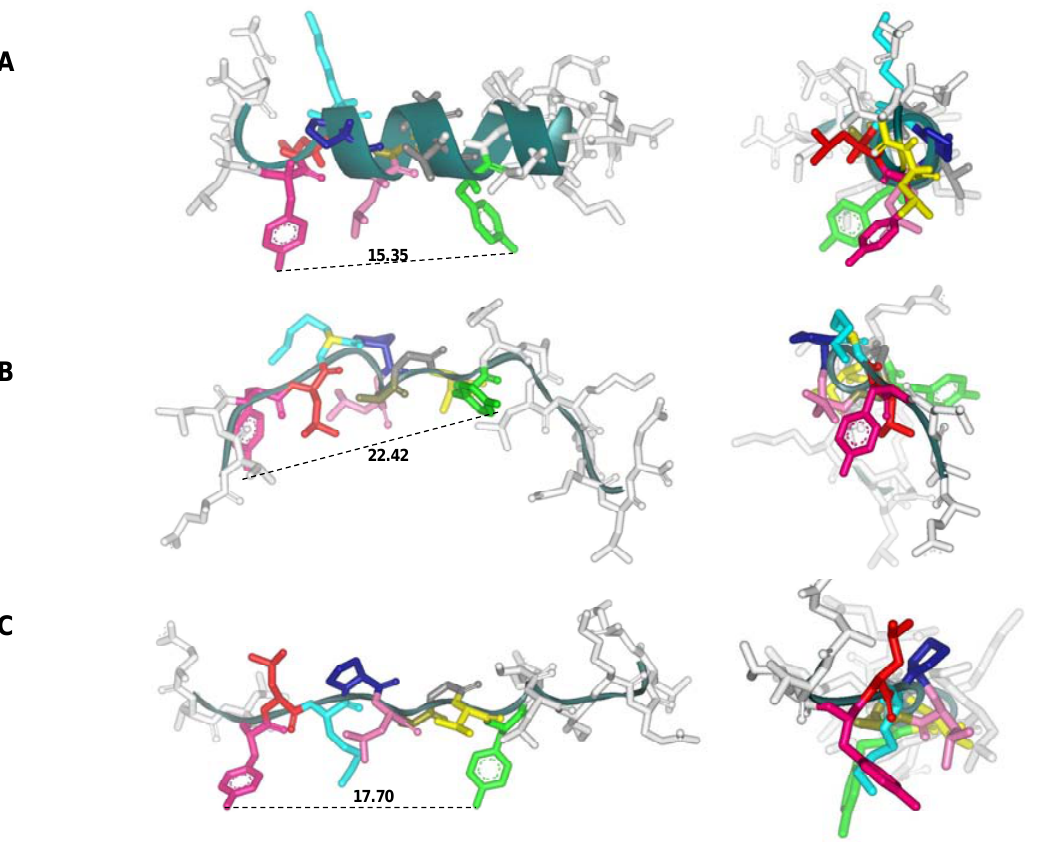
Figure 7. Conformational effects induced by D-substitutions in the all-L 1585 peptide 3D structure. The most representative structures for the parent all-L 1585 peptide and its D- partial substituted analogs and a reduced amide analog are analyzed respecting their 3D structure. Molecular distance between Y4 and Y12 is shown in Å. A. Native MSP-1 1282-1301 (1585 peptide). B. 25793 ( D Y4). C. 25797 ( D L5). D. 25801 ( D K6). E. 25805 ( D P7).